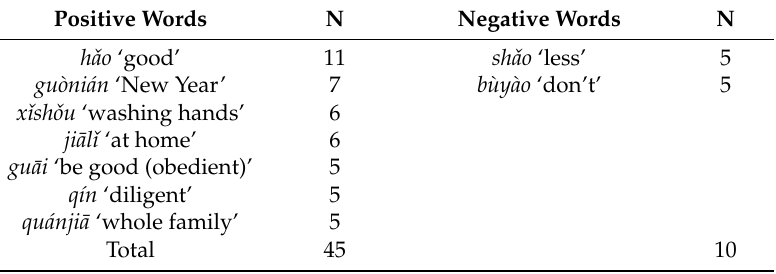
Table 6. Words with frequencies of 5 and over that appeared in ‘Humorous’ banners; N = 55. Positive